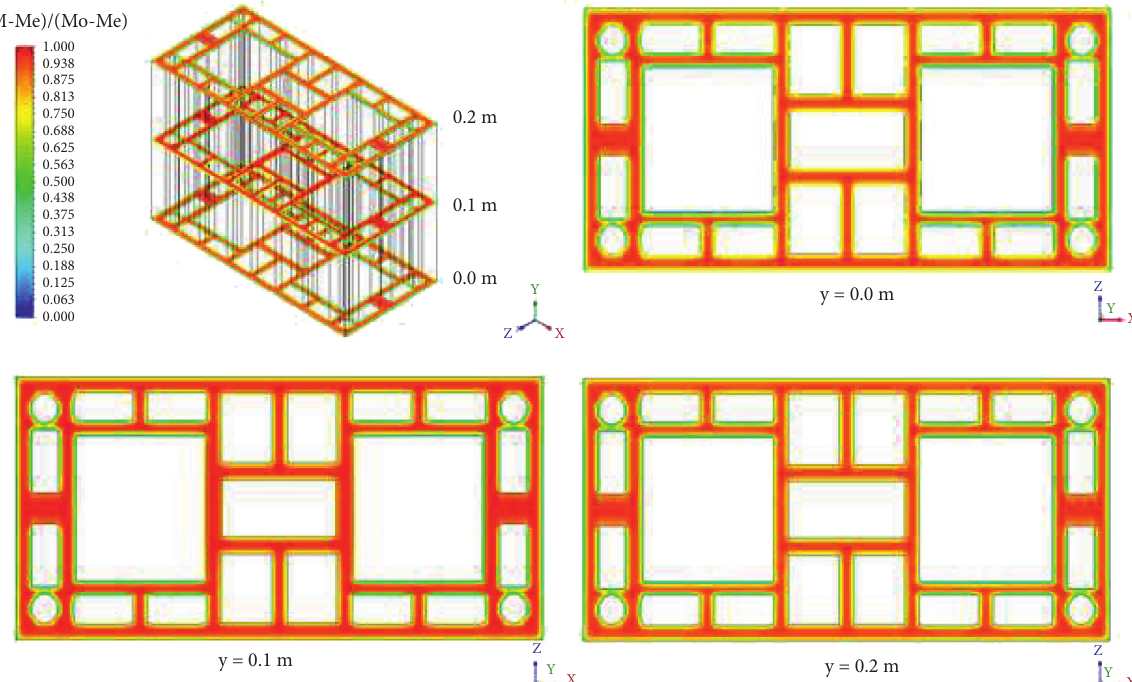
Figure 15: Dimensionless moisture field in the brick, at different planes XZ with the elapsed time of 30 minutes ( T � 80 ° C, RH �